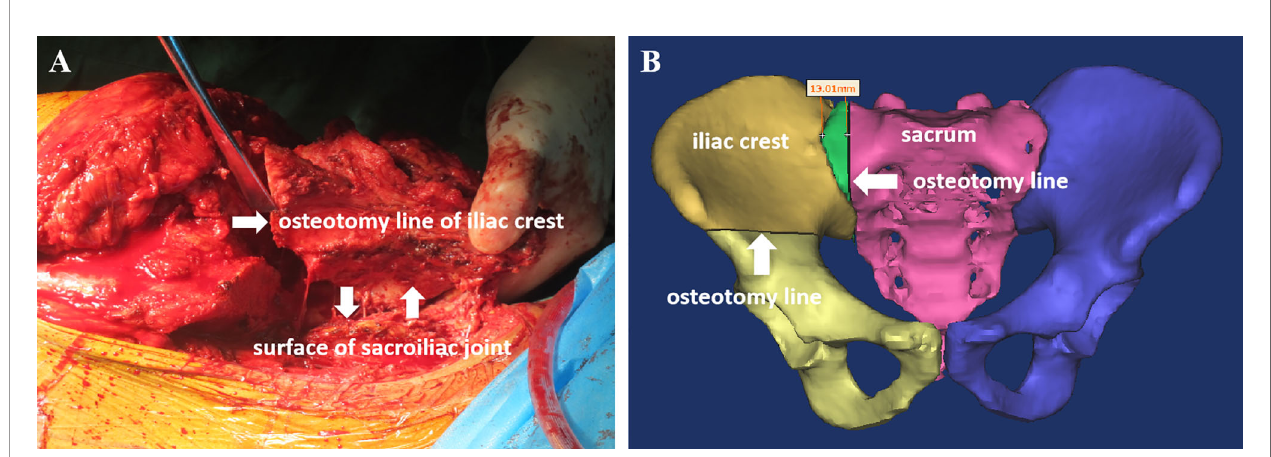
FIGURE 2 | Diagram of resection of iliac bone and sacroiliac joint. (A) The tumor is separated and resected by separating the sacroiliac joint. (B) For tumors involving the sacrum, part of the sacrum is removed, while the sacral nerves are